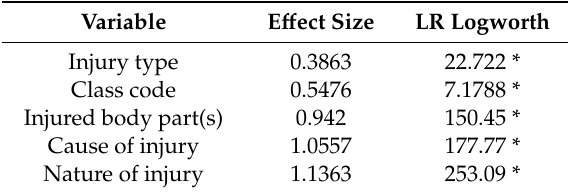
Table 4. Description of variables used in the